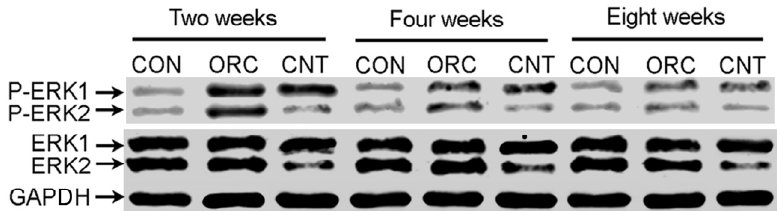
Figure 2. The relative ERK1/2 and phosphorylated p-ERK1/2 protein levels of the posterior joint capsule in the three groups at 2, 4 and 8 weeks after operation as determined by western blotting.